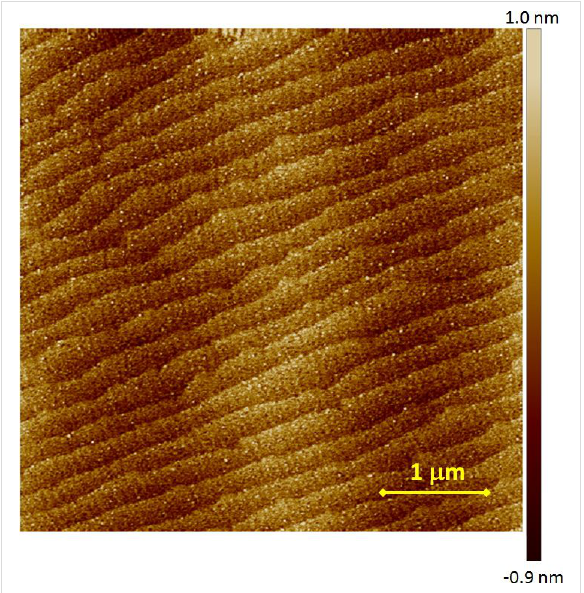
Figure 3: AFM image of 25 nm thick La 2 NiO 4 film on STO substrate.